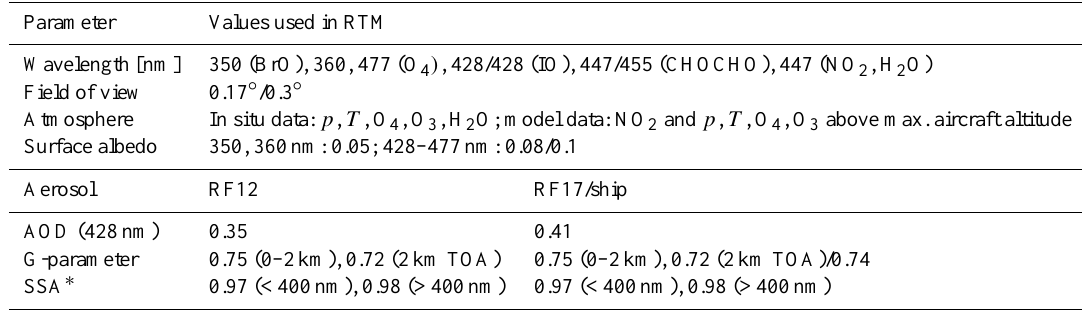
Table 4. AMAX/SMAX RTM